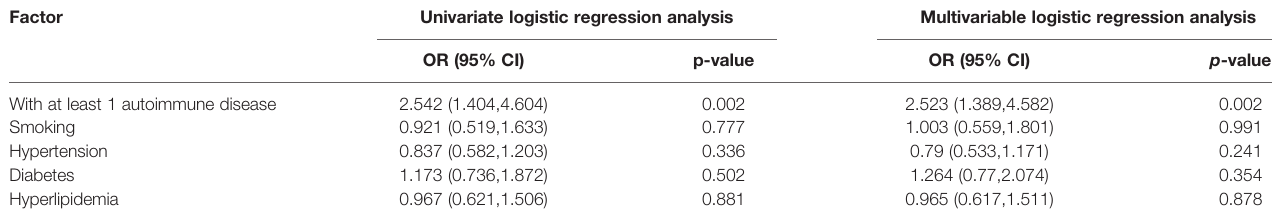
TABLE 5 | Conditional multivariable logistic regression analysis in SCCAD patients without IMH.